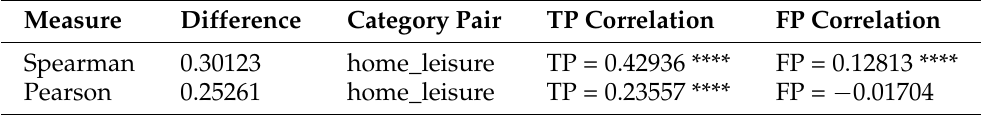
Table 43. Home and Leisure in